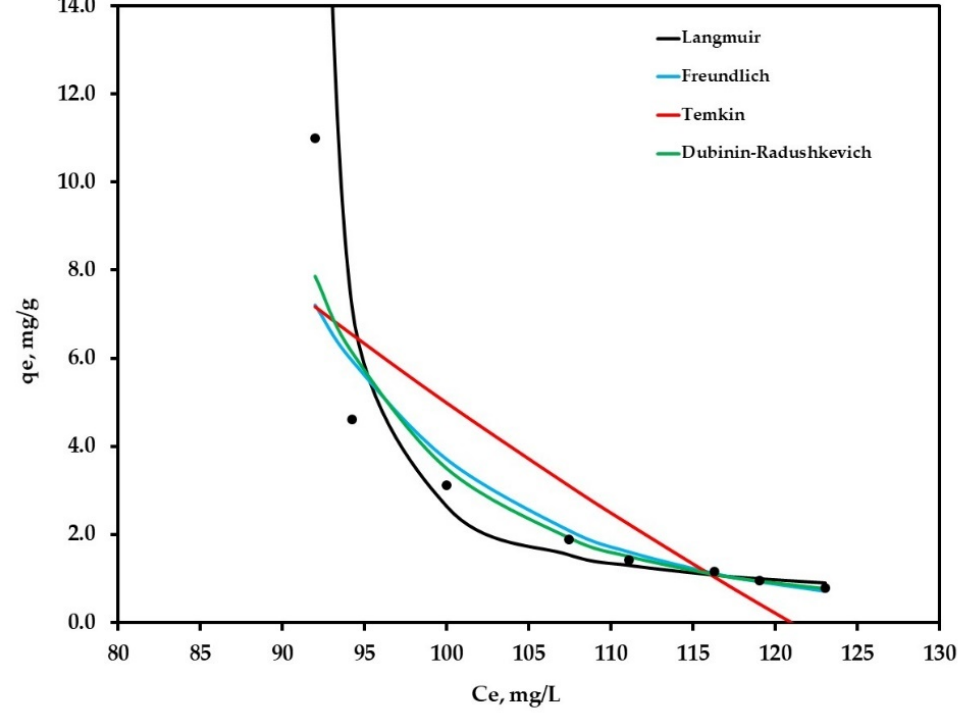
Figure 5. Plot of equilibrium experimental data and calculated equilibrium data using different isotherm models for the adsorption of Cr (VI) on JTT, with an initial Cr (VI) concentration of 200 mg/L, temperature 25 °C, initial pH 3.